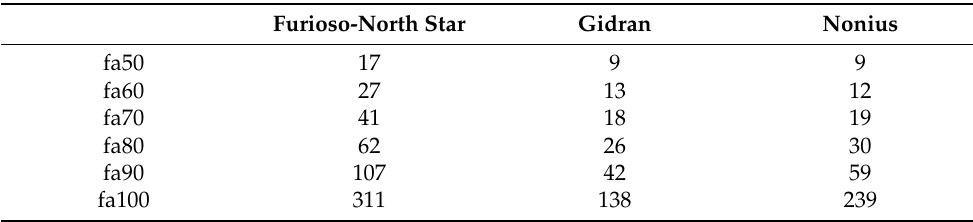
Table 5. Concentration of genetic variability in the reference